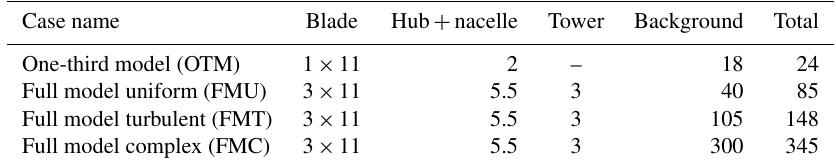
Figure 2. Details of the meshes. Table 1. Mesh sizes in millions.